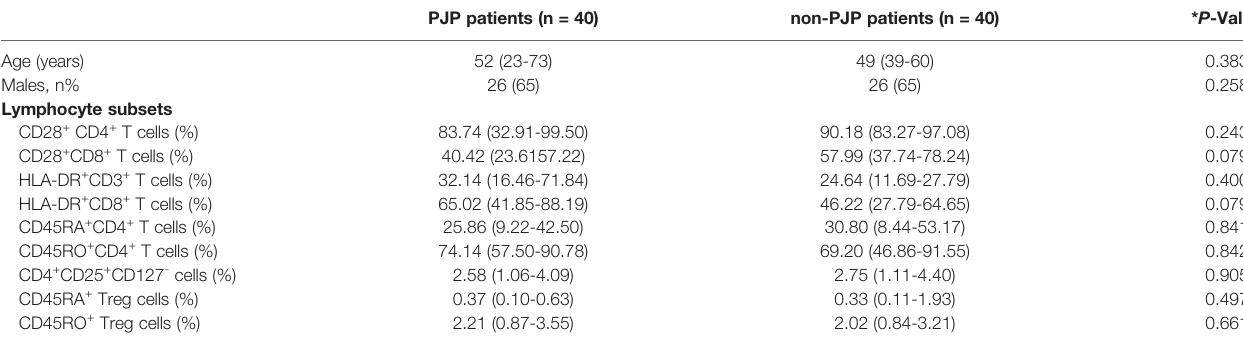
TABLE 3 | Analysis of the phenotype of lymphocytes in PJP and non-PJP